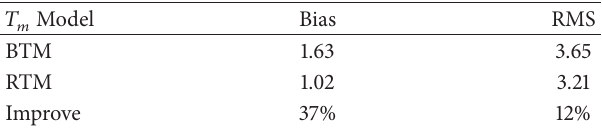
Table 7: Bias and RMS of the PWVs resulting from the BTM and seasonal two-factor RTMs-derived 𝑇 𝑚 at the Chenzhou station